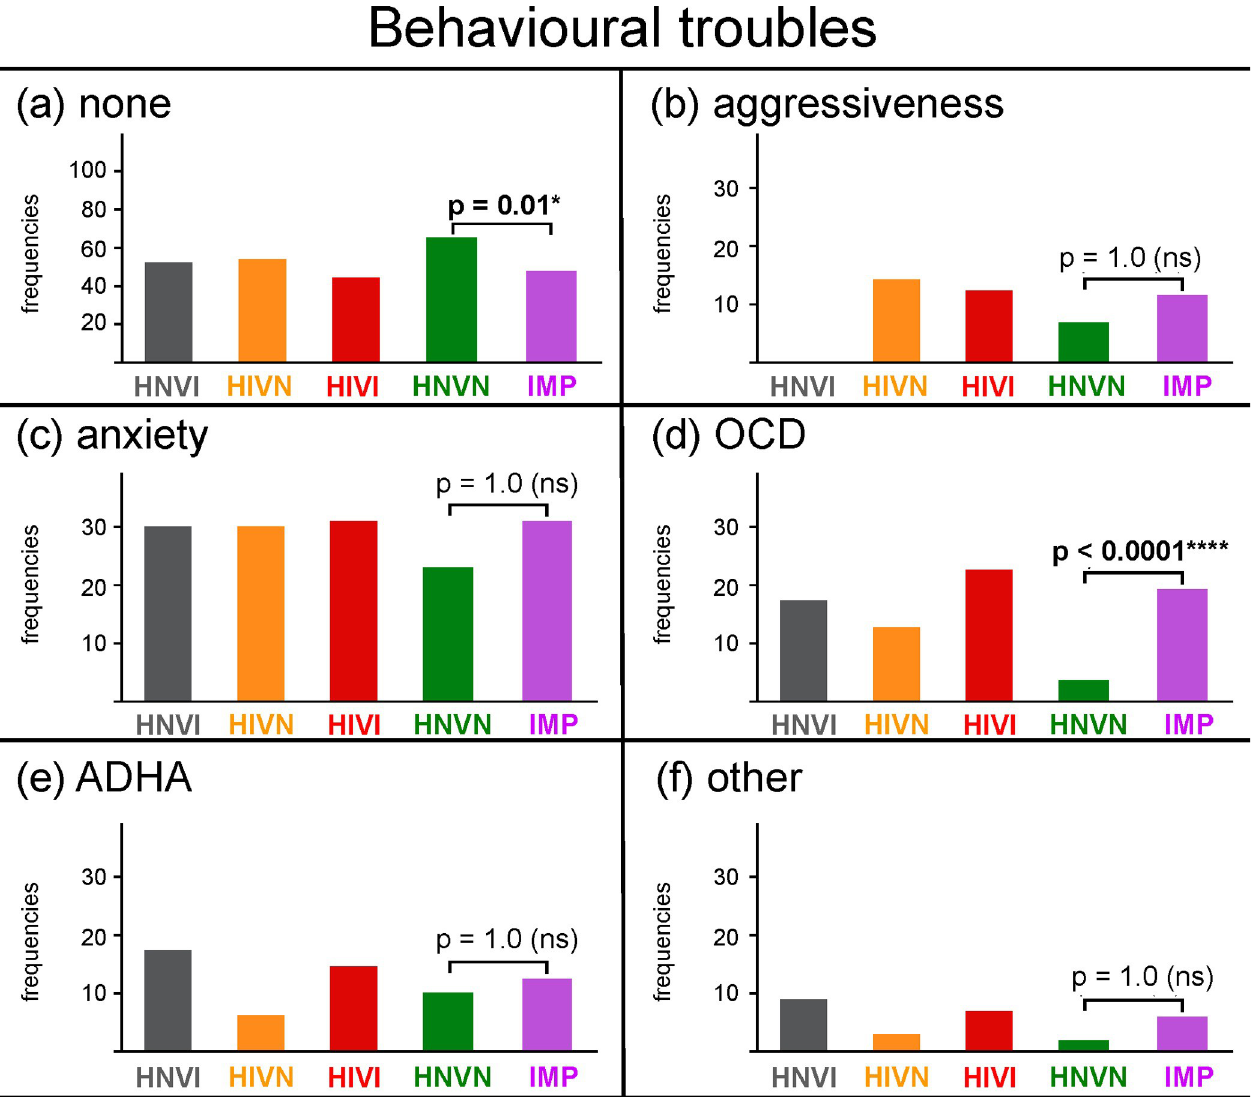
Fig 6. Frequencies of responses, in percentages, obtained for each group and for the IMP cohort for the following behavioural troubles: (a) none, (b) aggressiveness, (c) anxiety, (d) obsessive-compulsive disorder (OCD), (e) attention-deficit/hyperactivity (ADHD), and (f) other. The ordinate width is larger in panel (a) than in panels (b) to (f). HNVI = hearing normal vision impaired (grey), HIVN = hearing impaired vision normal (orange), HIVI = hearing impaired vision impaired (red), HNVN = hearing normal vision normal (green), IMP = impaired (HNVI, HIVN and HIVI gathered, purple), ns = non significant. Horizontal brackets show comparisons between HNVN and IPM assessed using Chi 2